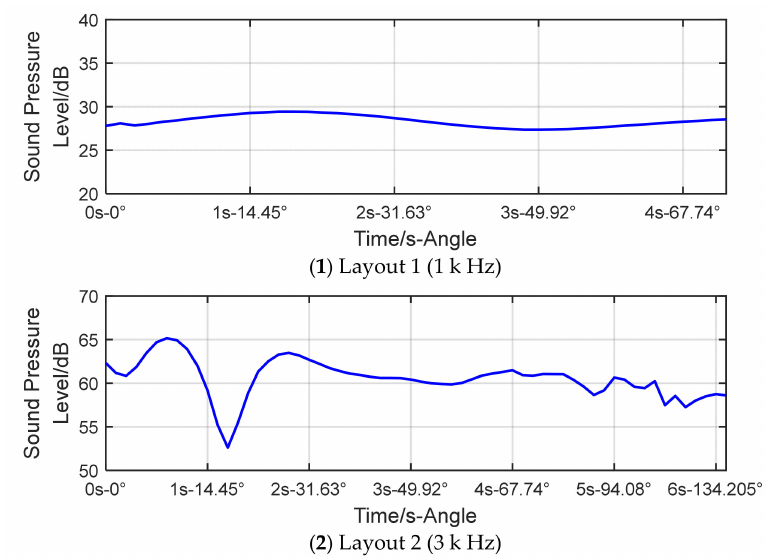
Figure 10. Sound pressure level on one of the microphones versus